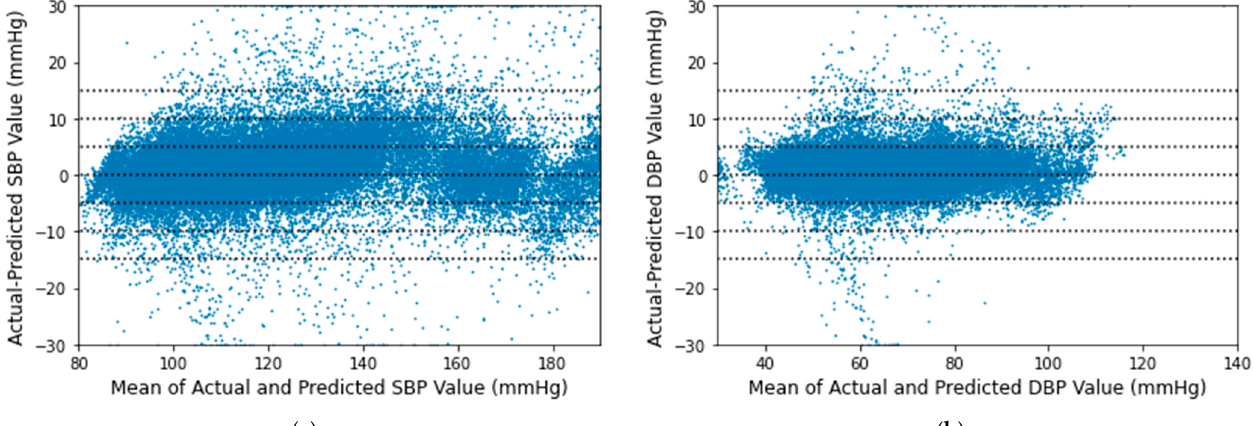
Figure 14. Bland–Altman scatterplot for ( a ) SBP and ( b ) DBP values.